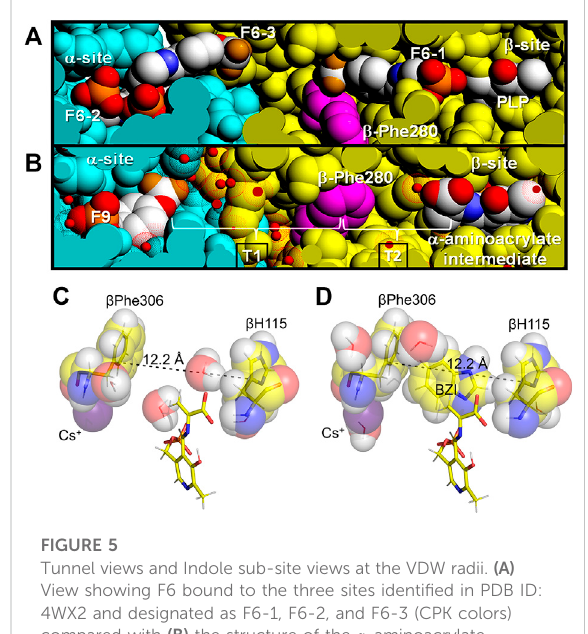
FIGURE 5 Tunnel views and Indole sub-site views at the VDW radii. (A) View showing F6 bound to the three sites identi fi ed in PDB ID: 4WX2 and designated as F6-1, F6-2, and F6-3 (CPK colors) compared with (B) the structure of the α -aminoacrylate intermediate (PDB ID: 4HN4). In these VDW views, some of the amino acid residues forming the channel have been cut away (slabbed) to expose the tunnel interior and reveal the locations of the three F6 molecules bound within the tunnel and the α -site. Watermoleculesareshownassmallredballsinsidedotsurfacesat the VDW radius of oxygen. Color scheme: α -subunit residues, powder blue, β -subunit residues gold. The location of β Phe280 (magenta) is also shown. The brackets indicate the hydrophilic (T1) and hydrophobic (T2) regions of the tunnel. Figure redrawn from Hilario et al. (2016). (C) VDW contact structural detail of the β - subunit indole sub-site in E(A – A) (PDB ID: 4HN4) with hydrogens (white) modeled onto the heavy atoms. (D) E(A – A) (BZI) complex (PDB ID: 4HPX) showing structure detail of the indole subsite occupied by theindole isostereBZI including the VDW contacts of BZI with residues β Phe306 and β H115. The subsite distance of 12.2 Åis justrightto bind BZI. The monovalent cation sitesinthese structures are occupied by Cs + . Coloring scheme: carbons, yellow and in VDW spheres overlapping the stick representations, while the Cs + ions are colored